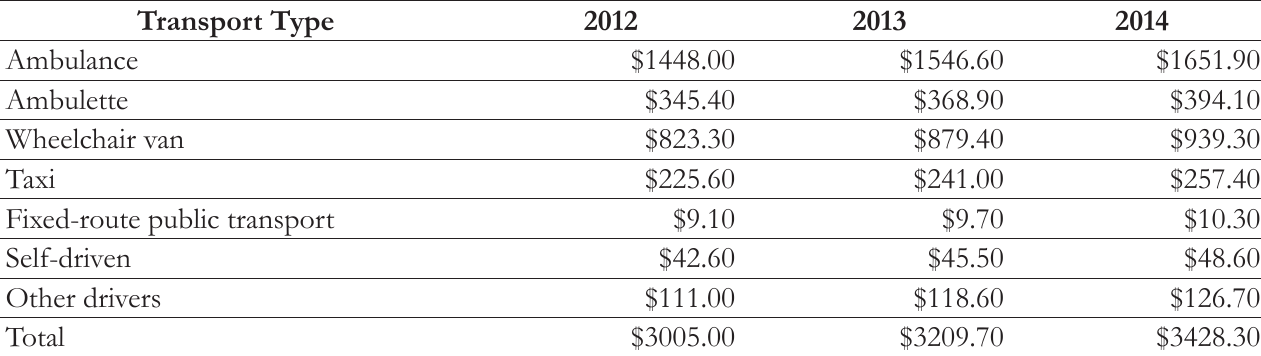
Table 5. Estimated National Costs of Dialysis Transportation from 2012 to 2014, by Transport Type ($